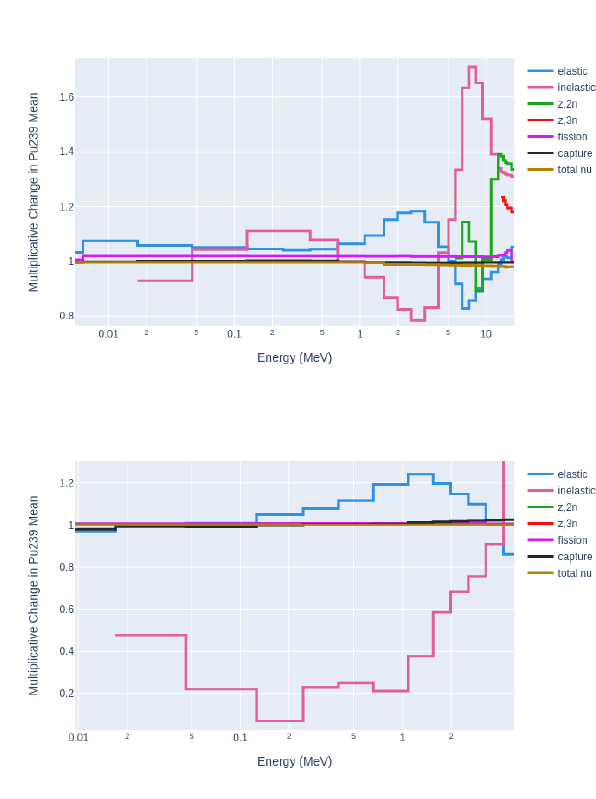
Figure 9. The same as the top-plot of Fig. 5 except for adjust- ment to Pu LLNL pulsed-sphere neutron-leakage spectra mea- sured with a sphere of 0.7 mean-free path, at 26 degree with an NE-213 detector (top) and Pu reactivity coe ffi cients measured in Jezebel